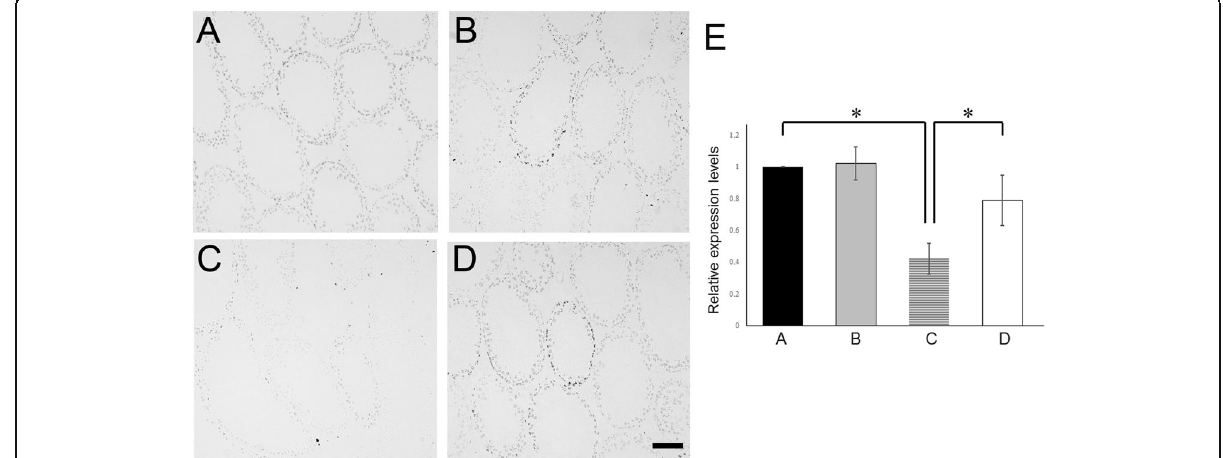
Fig. 3 After irradiation and TJ107 treatment shows proliferating cells in the testes. Samples were assessed at day 120 for each group. Immunohistological detection of Ki67 staining in testicular sections in Group A a , Group B b , Group C c , and Group D d . Ki67-positive nuclei of proliferating spermatogonia are indicated by dark brown spots, which were detected in almost all seminiferous tubules of the Group A a , Group B b , and Group D d on day 120. In the Group C c few seminiferous tubules with Ki67-positive cells were sporadically observed. Bar = 100 μ m. e Expression of Ki67 mRNA in the mouse testes of each group at 120 days. Calculation of Relative mRNA intensity was done, and the expression in the control group for each point was set to 1. The data are presented as mean ± standard deviation ( n = 10). Asterisks indicate p <